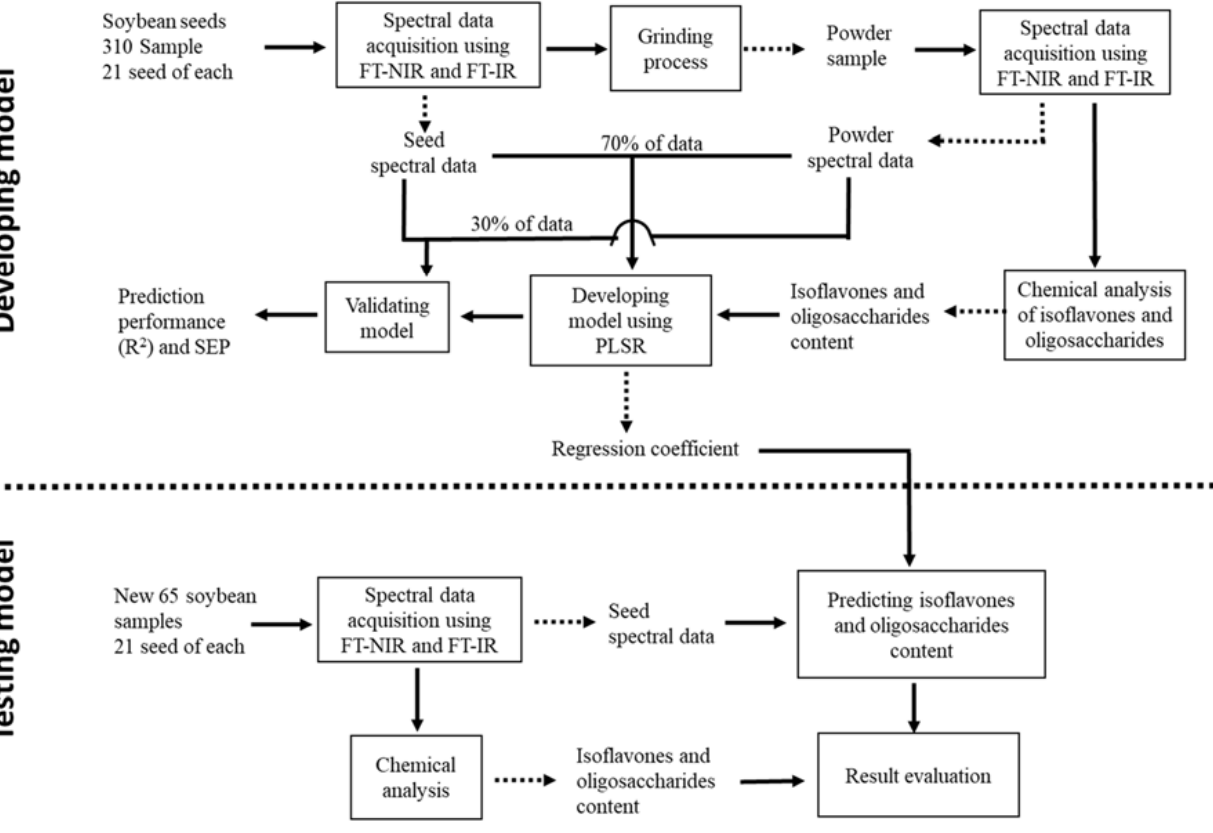
Figure 2. The experimental workflow to develop a model to predict isoflavones and oligosaccharides using FT-NIR and FT-IR spectroscopic techniques.